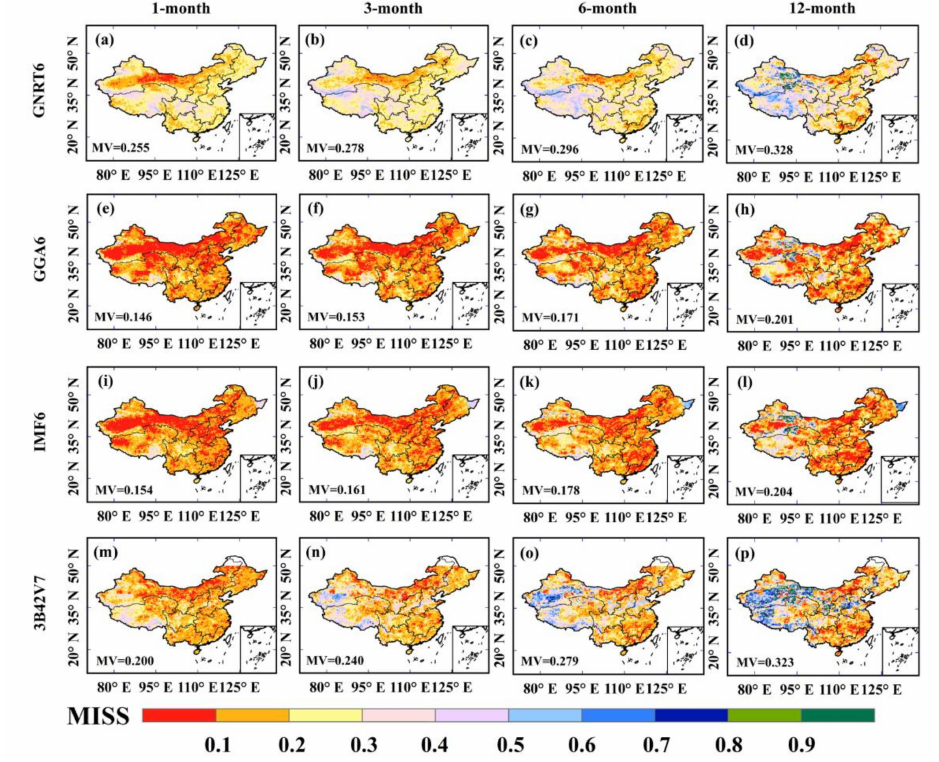
Figure 8. MISS of the ( a , e , i , m ) 1-, ( b , f , j , n ) 3-, ( c , g , k , o ) 6- and ( d , h , l , p ) 12-month SPEI based on the four SREs w.r.t in situ observa-tions in June 2000–May 2019. Columns for different time scales, rows for different